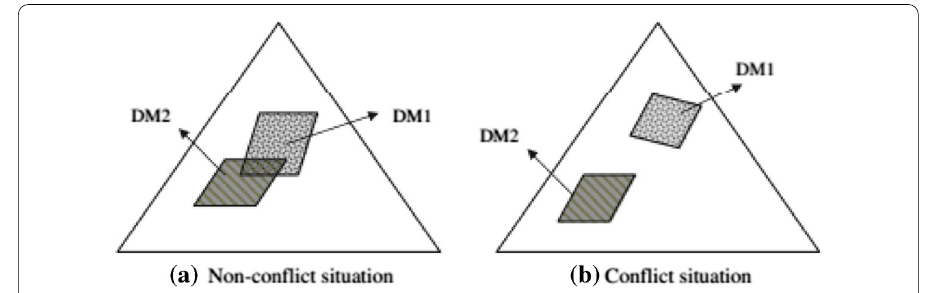
Fig. 4 Aggregation of results: non-conflict and conflict